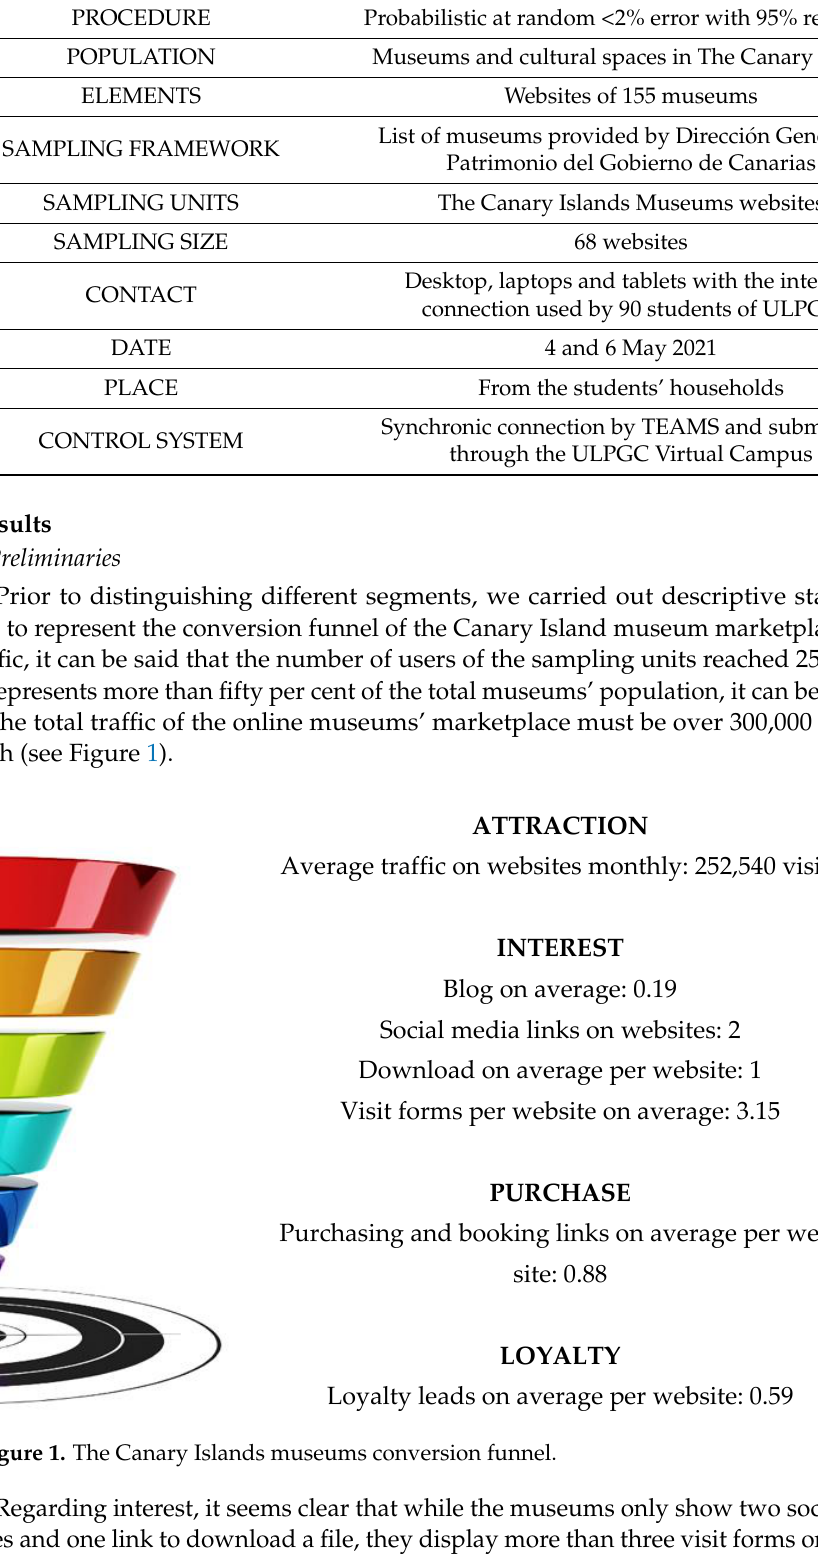
Table 4. Frequency and descriptive statistics of the Canary Islands´ museums websites. Descriptive Statistics N